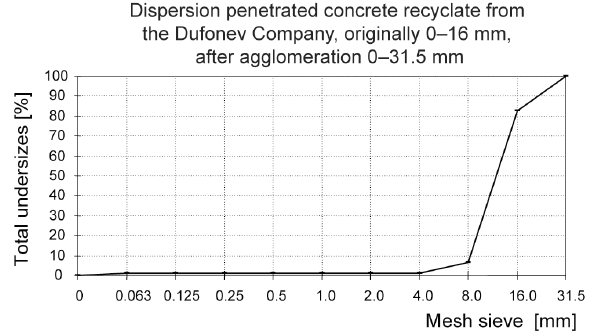
Fig. 3. Dispersion-penetrated and subsequently agglomerated Dufonev recyclate, fraction 0–31.5 mm (left); original raw Dufonev recyclate, fraction 0–16 mm (right)